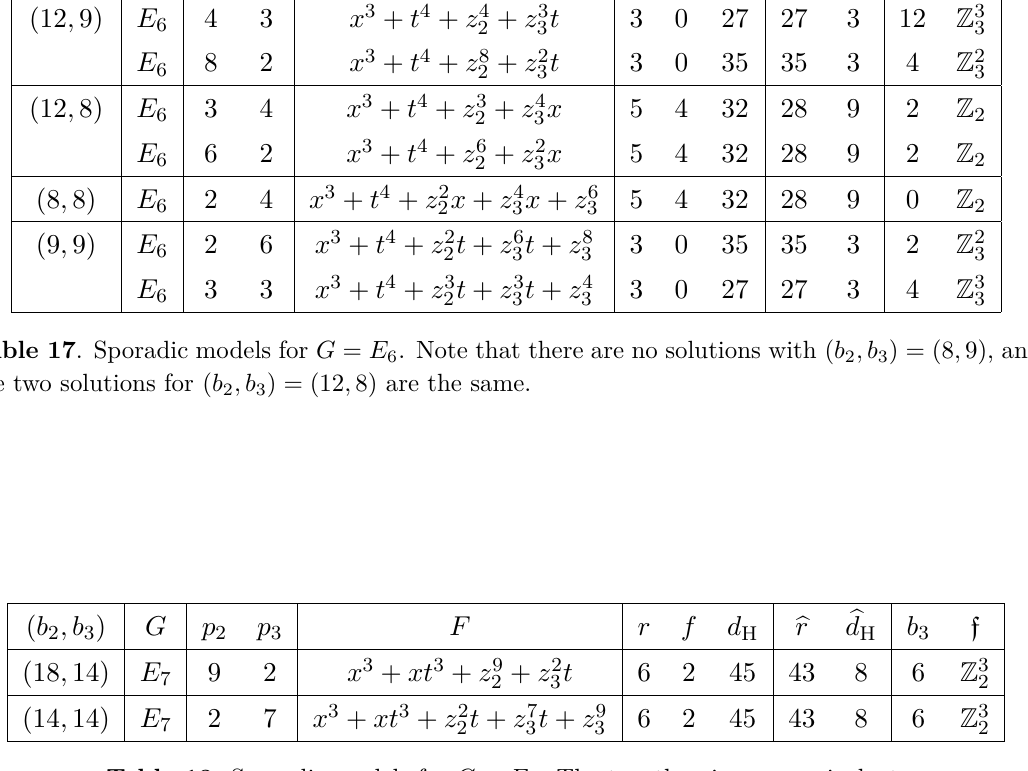
Table 18 . Sporadic models for G = E 7 . The two theories are equivalent.